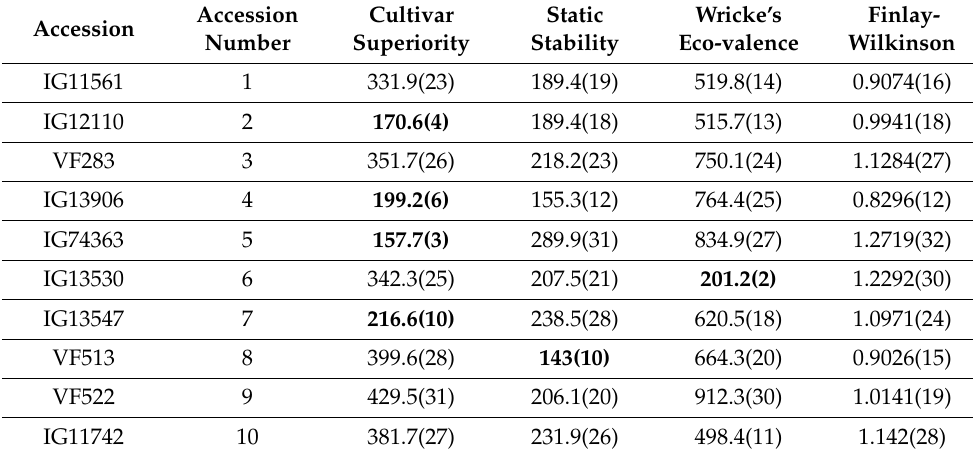
Table 4. Cultivar superiority index, static stability, Wricke’s eco-valence and Finlay and Wilkinson values for plant height of faba bean accessions evaluated in 12 different environments. Values marked in bold belong to the 10 most stable accessions, while values presented between brackets reflect their